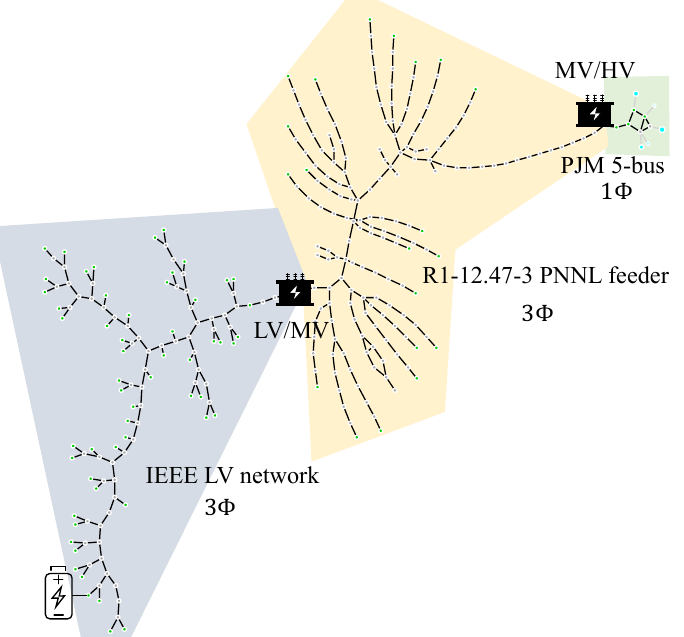
Figure 1. Energy arbitrage test system. PJM 5-bus (single-phase) + PNNL feeder (three-phase) + IEEE LV network (three-phase). The green nodes represent buses where loads are connected, gray nodes represent connecting buses, and the light blue nodes represent generation